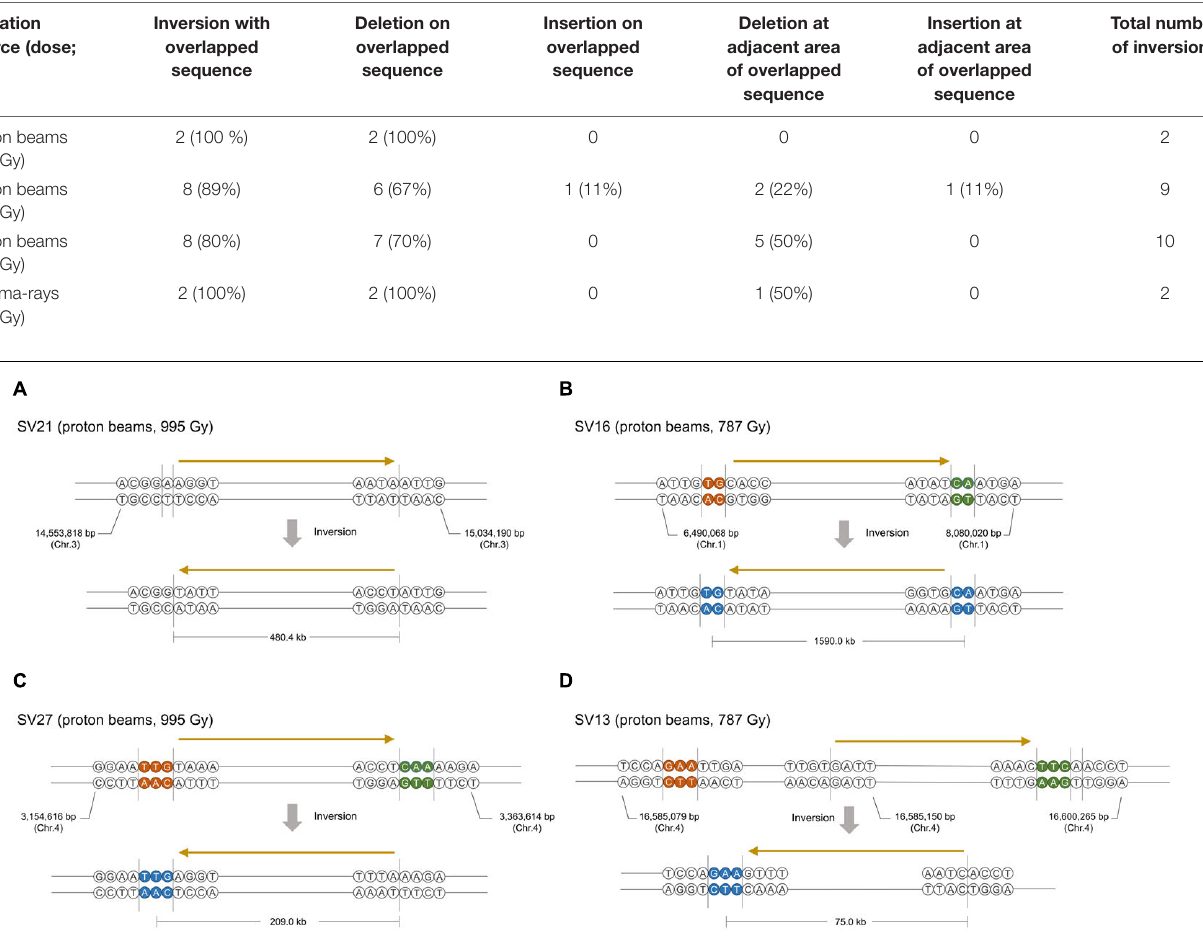
TABLE 3 | Classification of irradiation-induced inversions according to the characteristics of sequences near the junctions of inverted DNA regions. Radiation Source (dose;